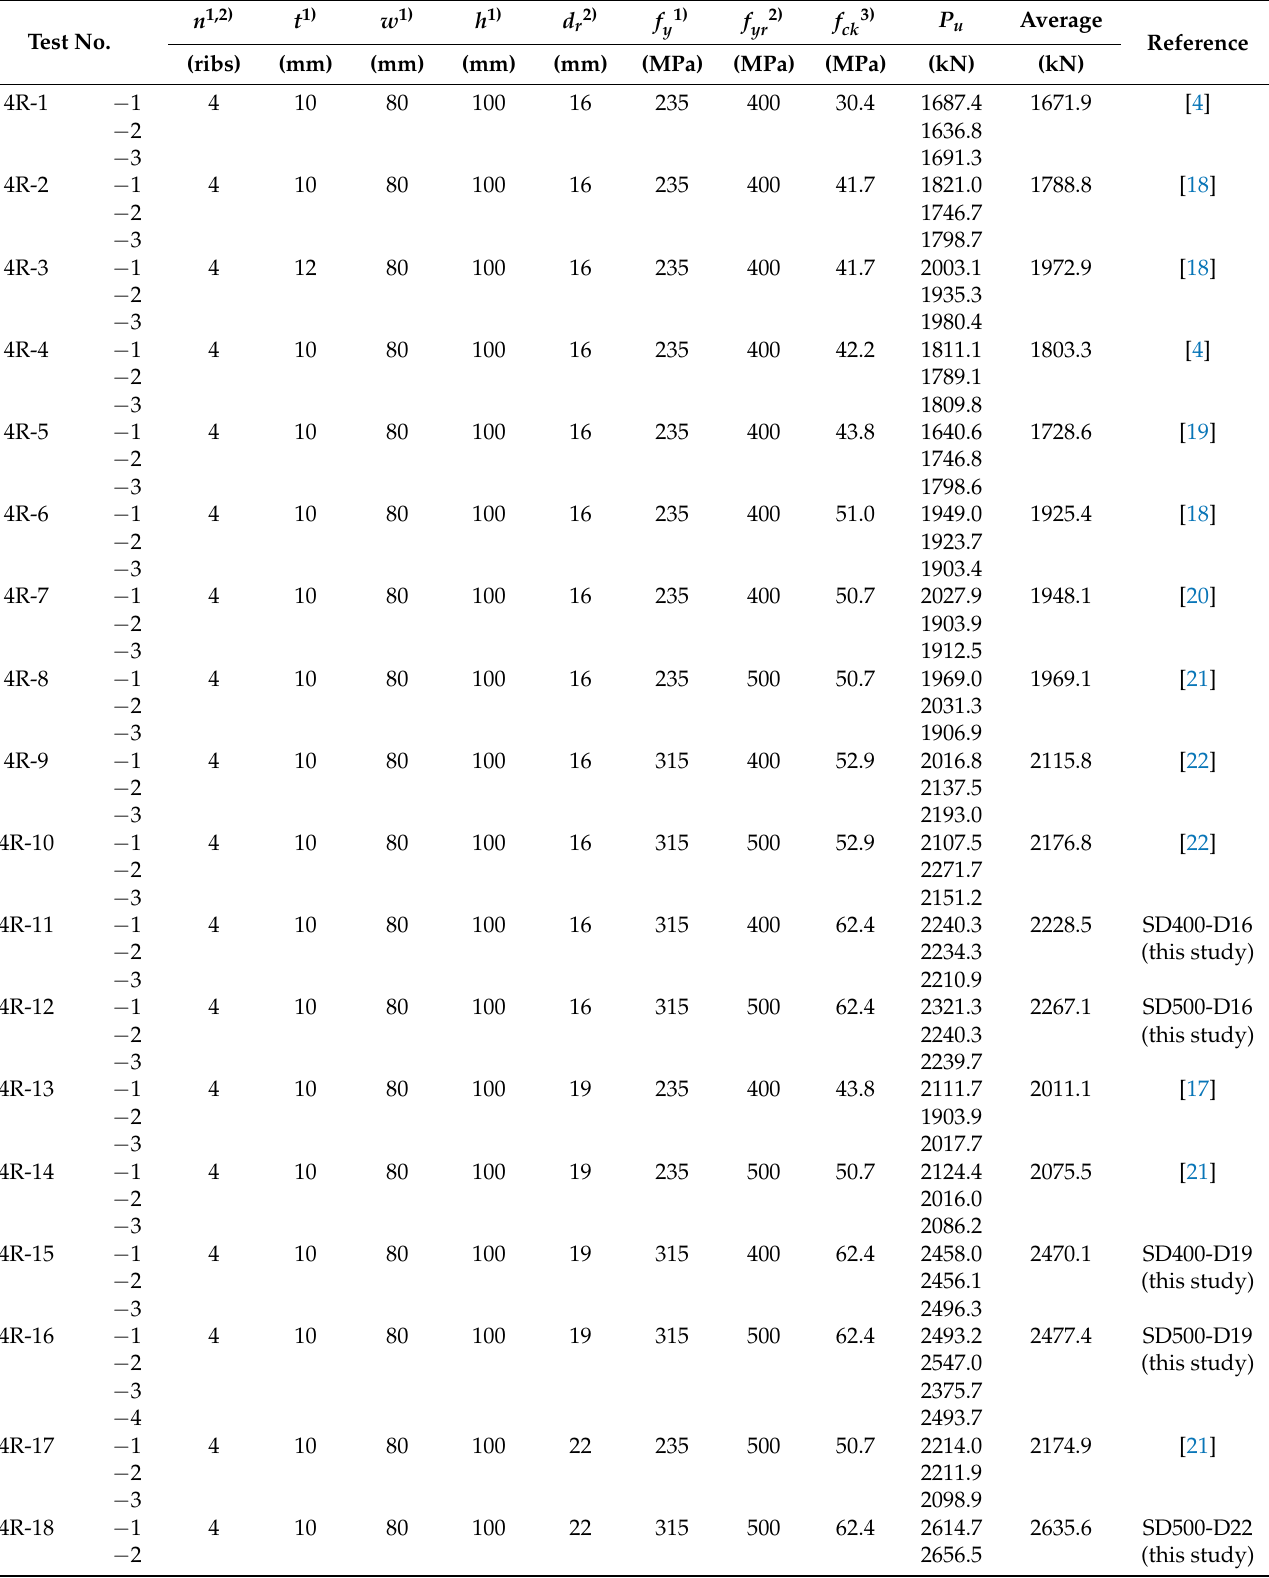
Table 5. Shear resistance data from push-out tests and numerical